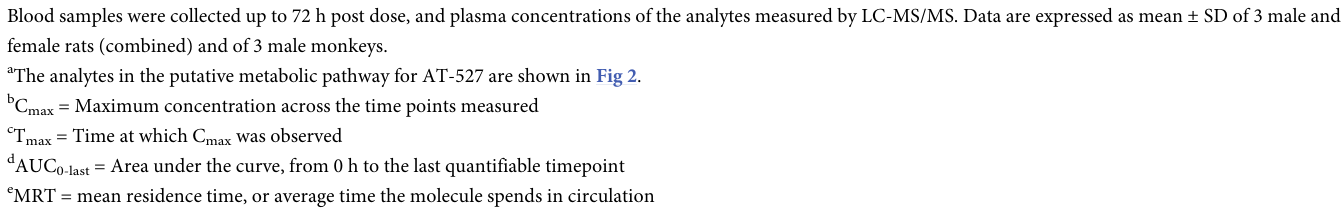
Blood samples were collected up to 72 h post dose, and plasma concentrations of the analytes measured by LC-MS/MS. Data are expressed as mean ± SD of 3 male and 3 female rats (combined) and of 3 male monkeys. a The analytes in the putative metabolic pathway for AT-527 are shown in Fig 2 . b C max = Maximum concentration across the time points measured c T max = Time at which C max was observed d AUC 0-last = Area under the curve, from 0 h to the last quantifiable timepoint e MRT = mean residence time, or average time the molecule spends in circulation